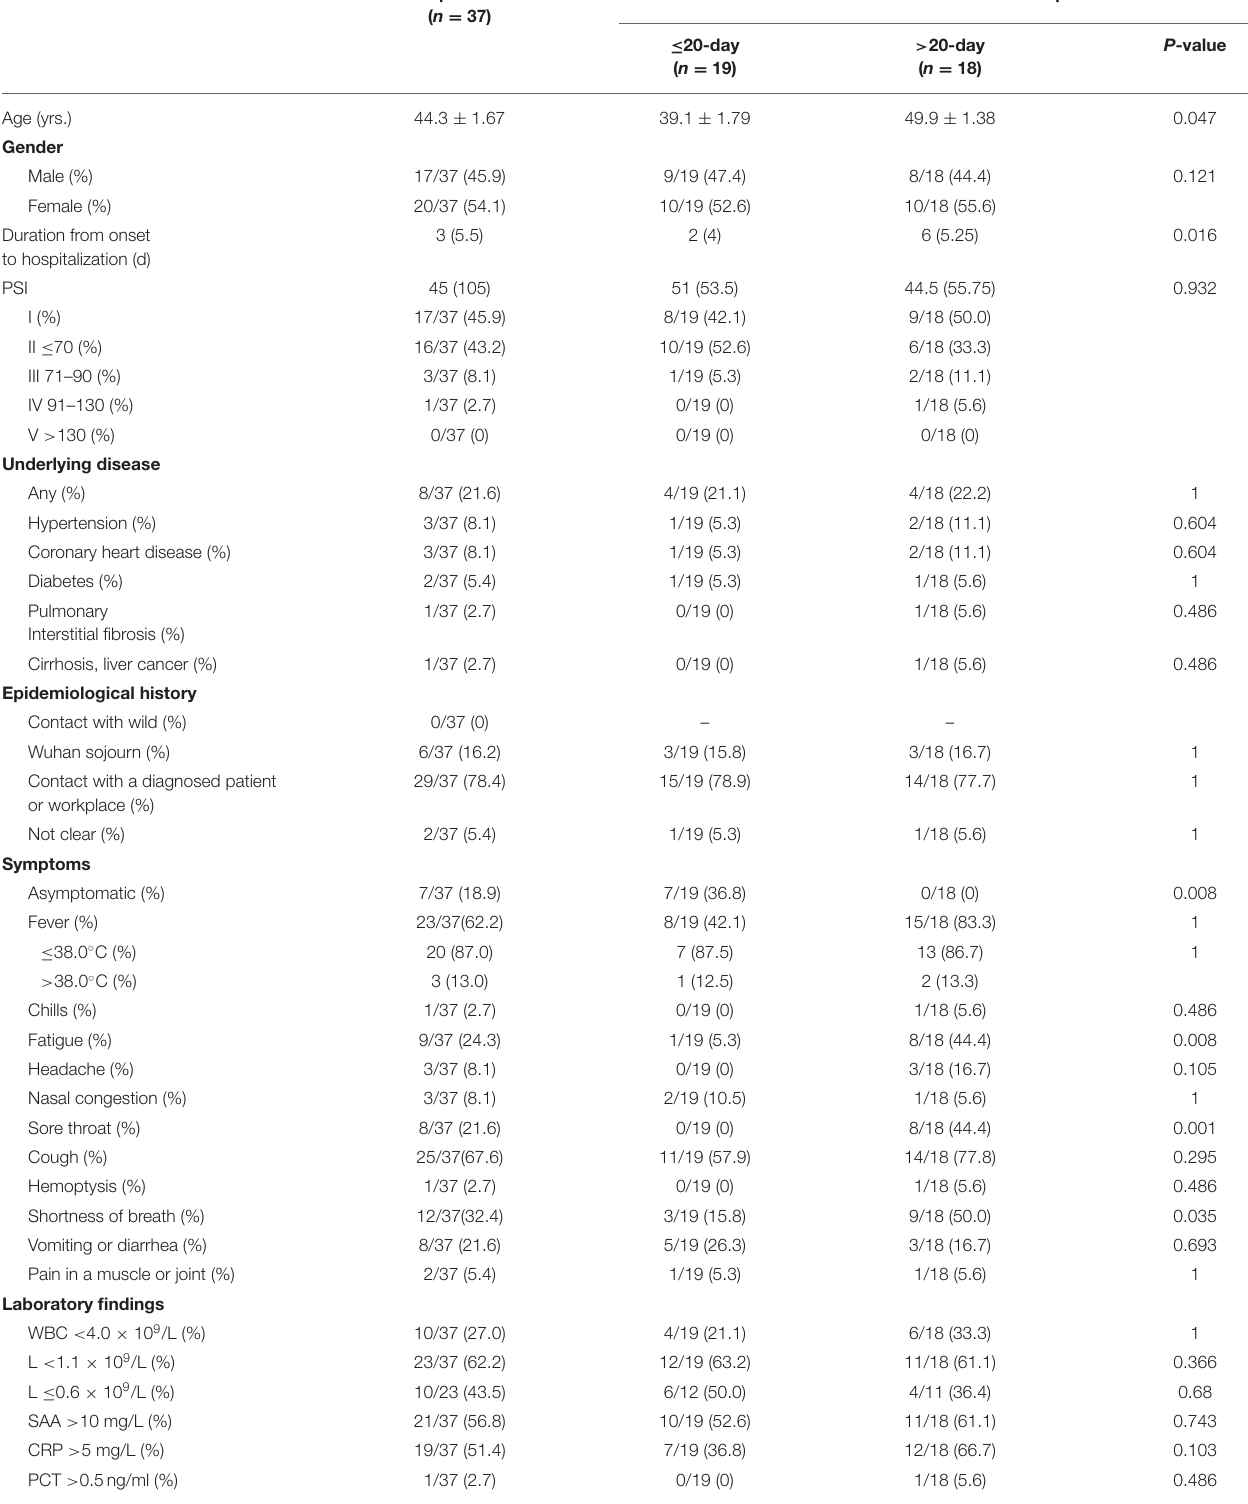
TABLE 1 | Clinical characteristics of the study patients on admission.